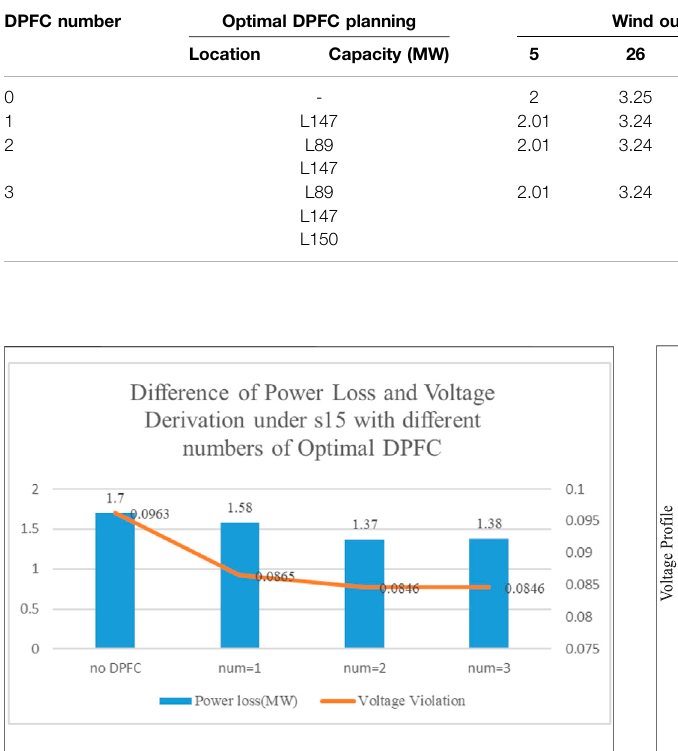
FIGURE 11 | Performance of power fl ow w/o DPFC.